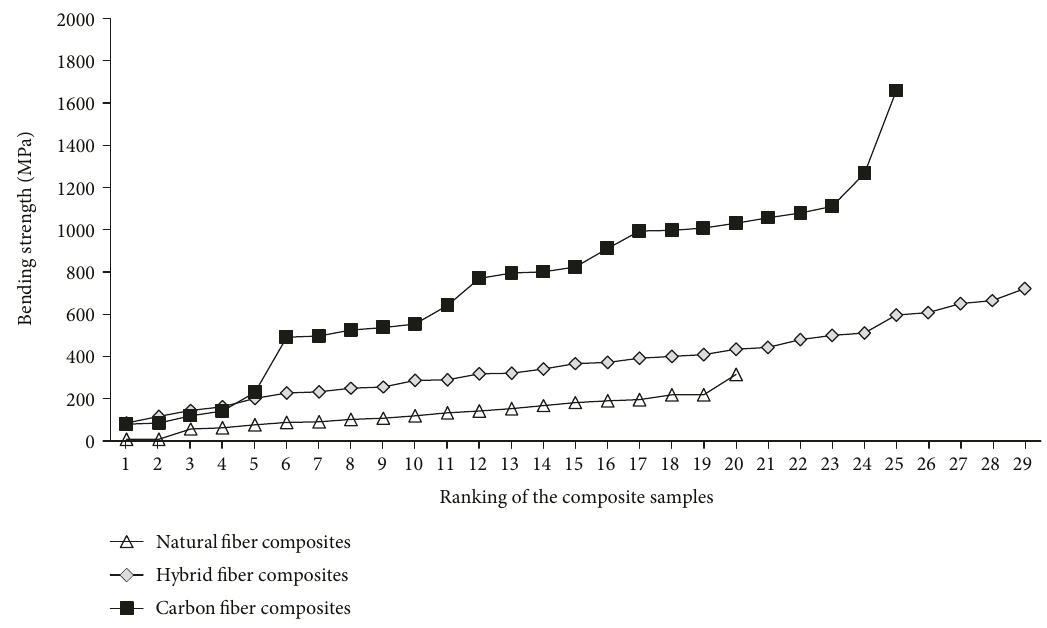
Figure 4: Bending strength of various hybrid carbon-/ fl ax- and nonhybrid fl ax- or carbon-epoxy composites [8, 9, 12, 13, 15, 17, 21, 22, 26, 40, 43, 45, 46, 51 – 55].